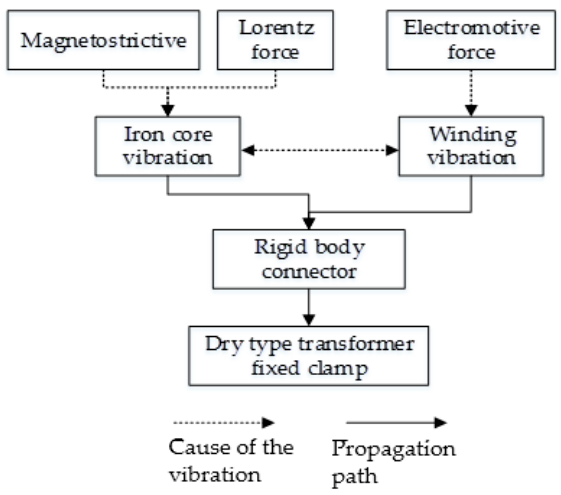
Figure 1. Dry-type transformer-vibration transmission route.